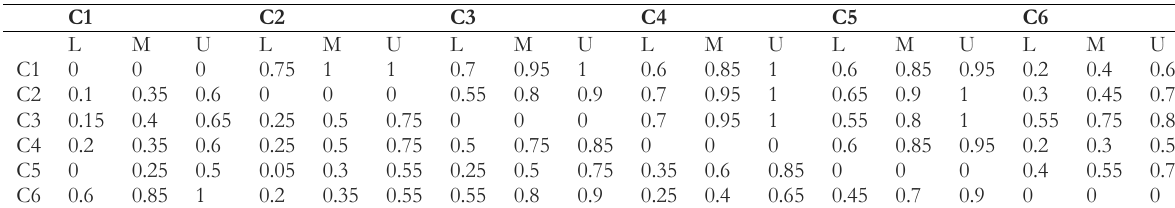
Table 4. Direct fuzzy relations matrix between the main problems of the human resource management system based on competencies.